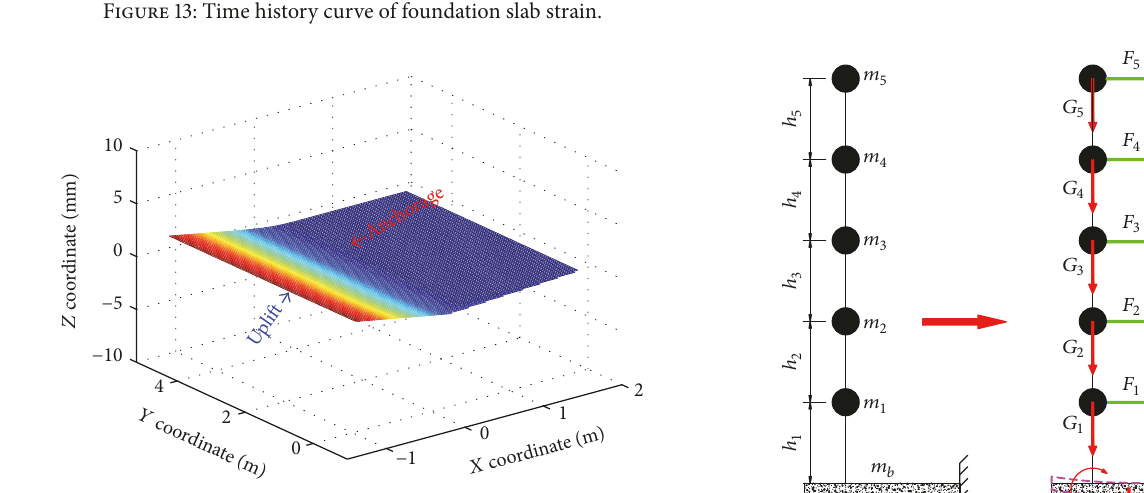
Figure 13: Time history curve of foundation slab strain.